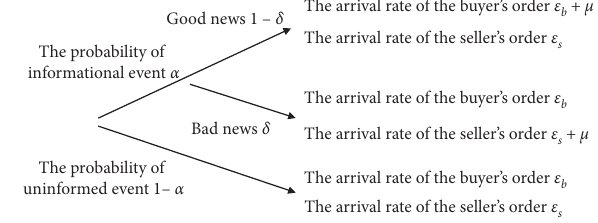
Figure 1: Simulation of a trader placing an